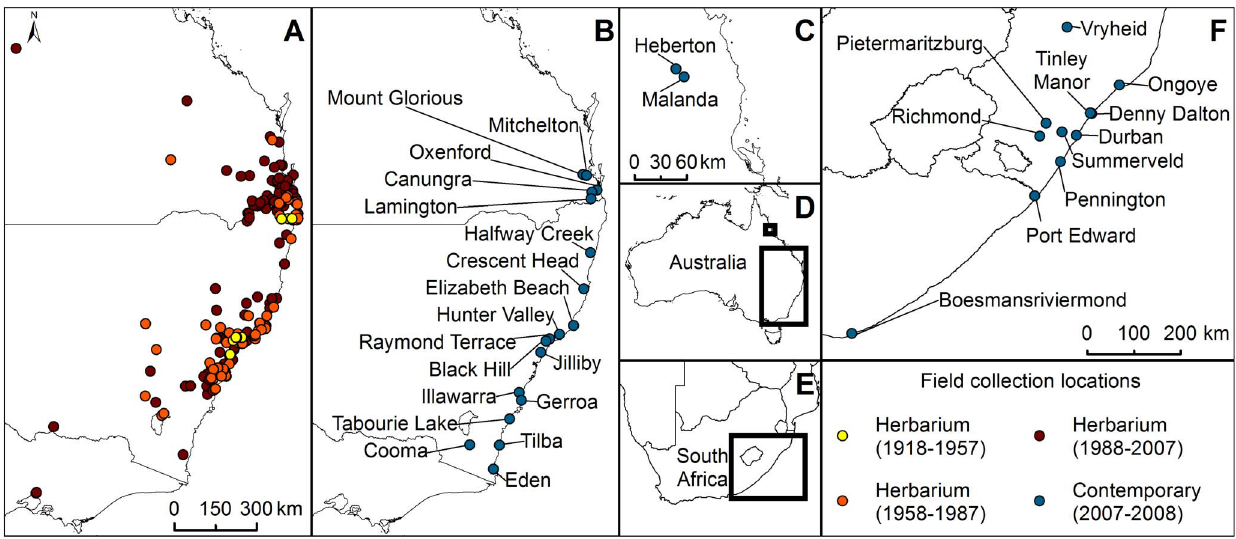
Figure 1. Senecio madagascariensis sampling locations. Geographic locations of: herbarium records sampled in Australia (A); contemporary collections in Australia (B, C) and South Africa (F). Extent maps indicating sampling areas in country-wide context (D, E).